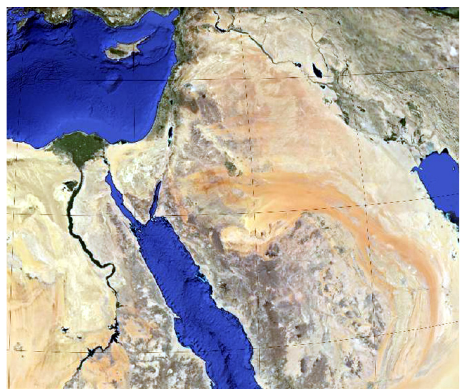
Fig. 1: North Africa and the Near East today. (Google